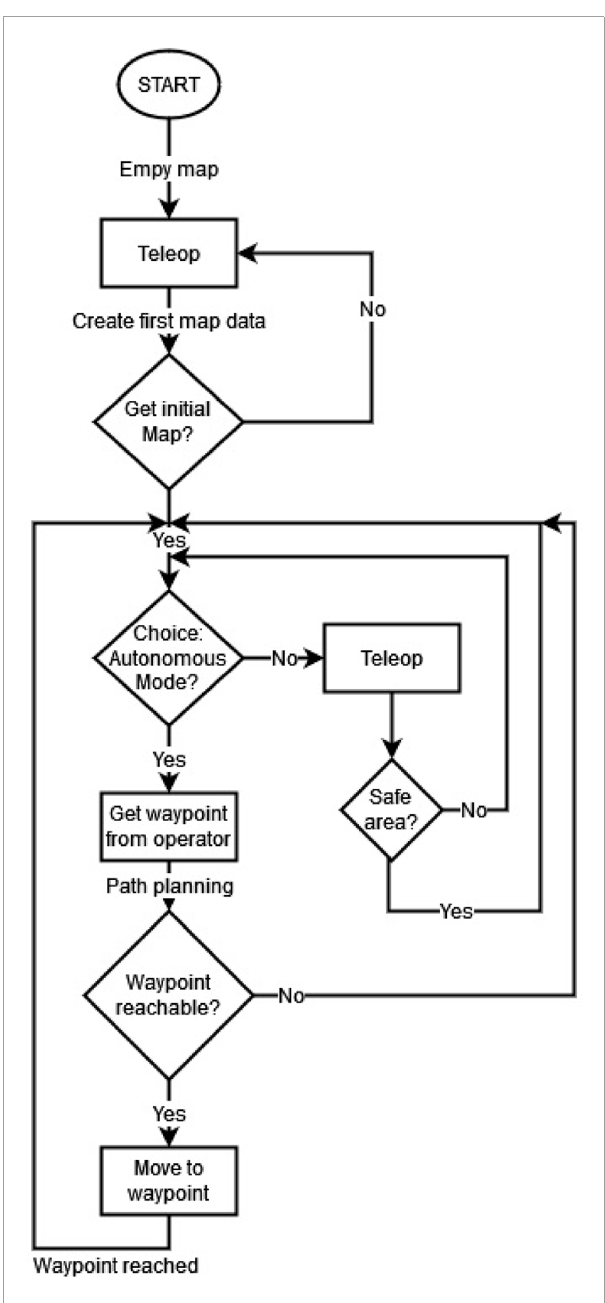
FIGURE 11 Work flow of the semi-autonomous approach based on receiving waypoints through a human operator and allowing